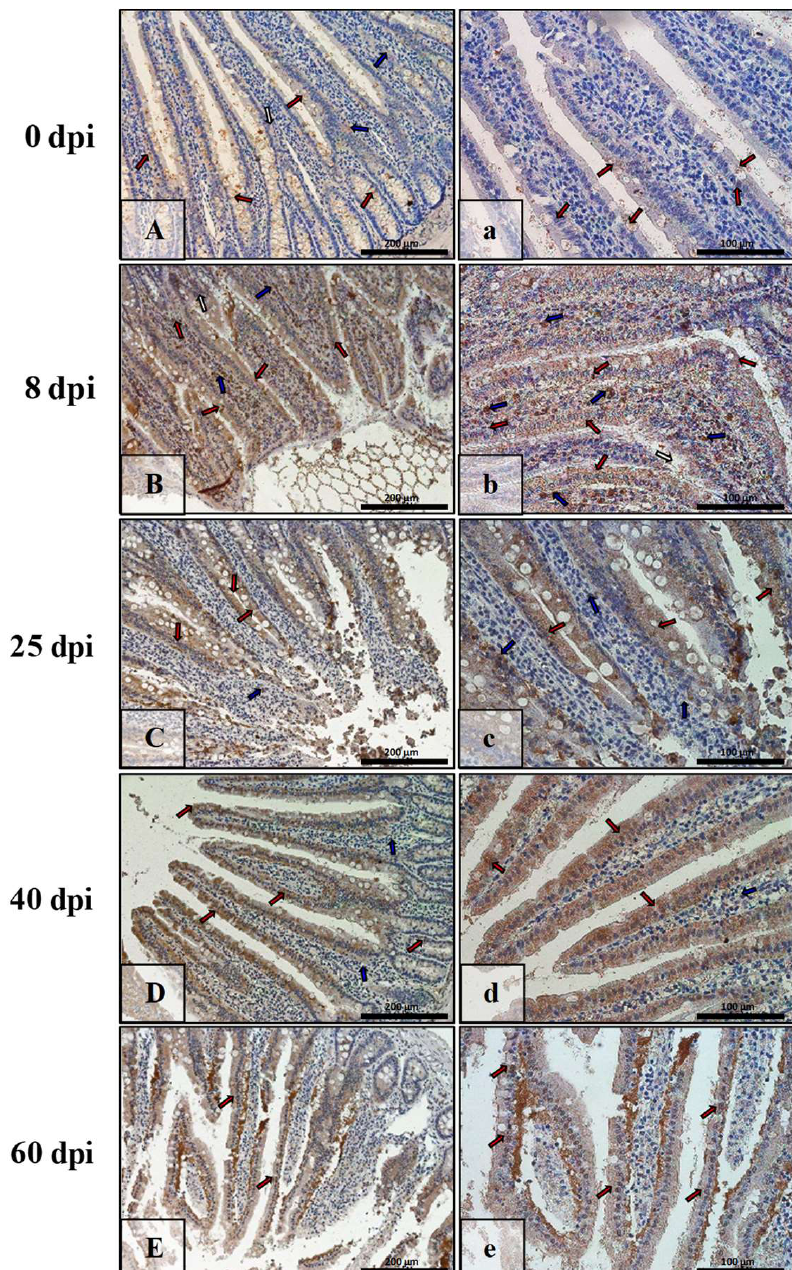
Figure 11. Representative microphotographs showing caspase-3 immunoexpression in the small intestine of control animals ( A , a ) and on subsequent days ( B , b , C , c , D , d , E , e ) after H. diminuta infection. Positive IHC reaction—brown reaction marked with arrows: red—epithelial cells of the villi and intestinal crypts, blue and white—cells in the connective tissue lining of the mucosa. Lens magnification: × 20 ( A – E , scale bar: 200 µ m), × 40 ( a – e , scale bar: 100 µ m).